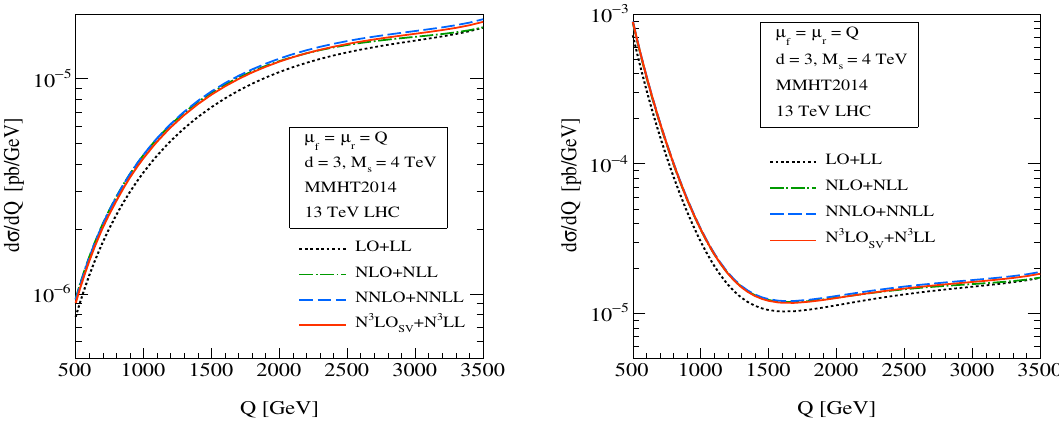
Figure 9 . Invariant mass distribution of di-lepton pair at LHC center of mass energy 13 TeV for pure ADD (left) and signal (right) for di(cid:11)erent resummed